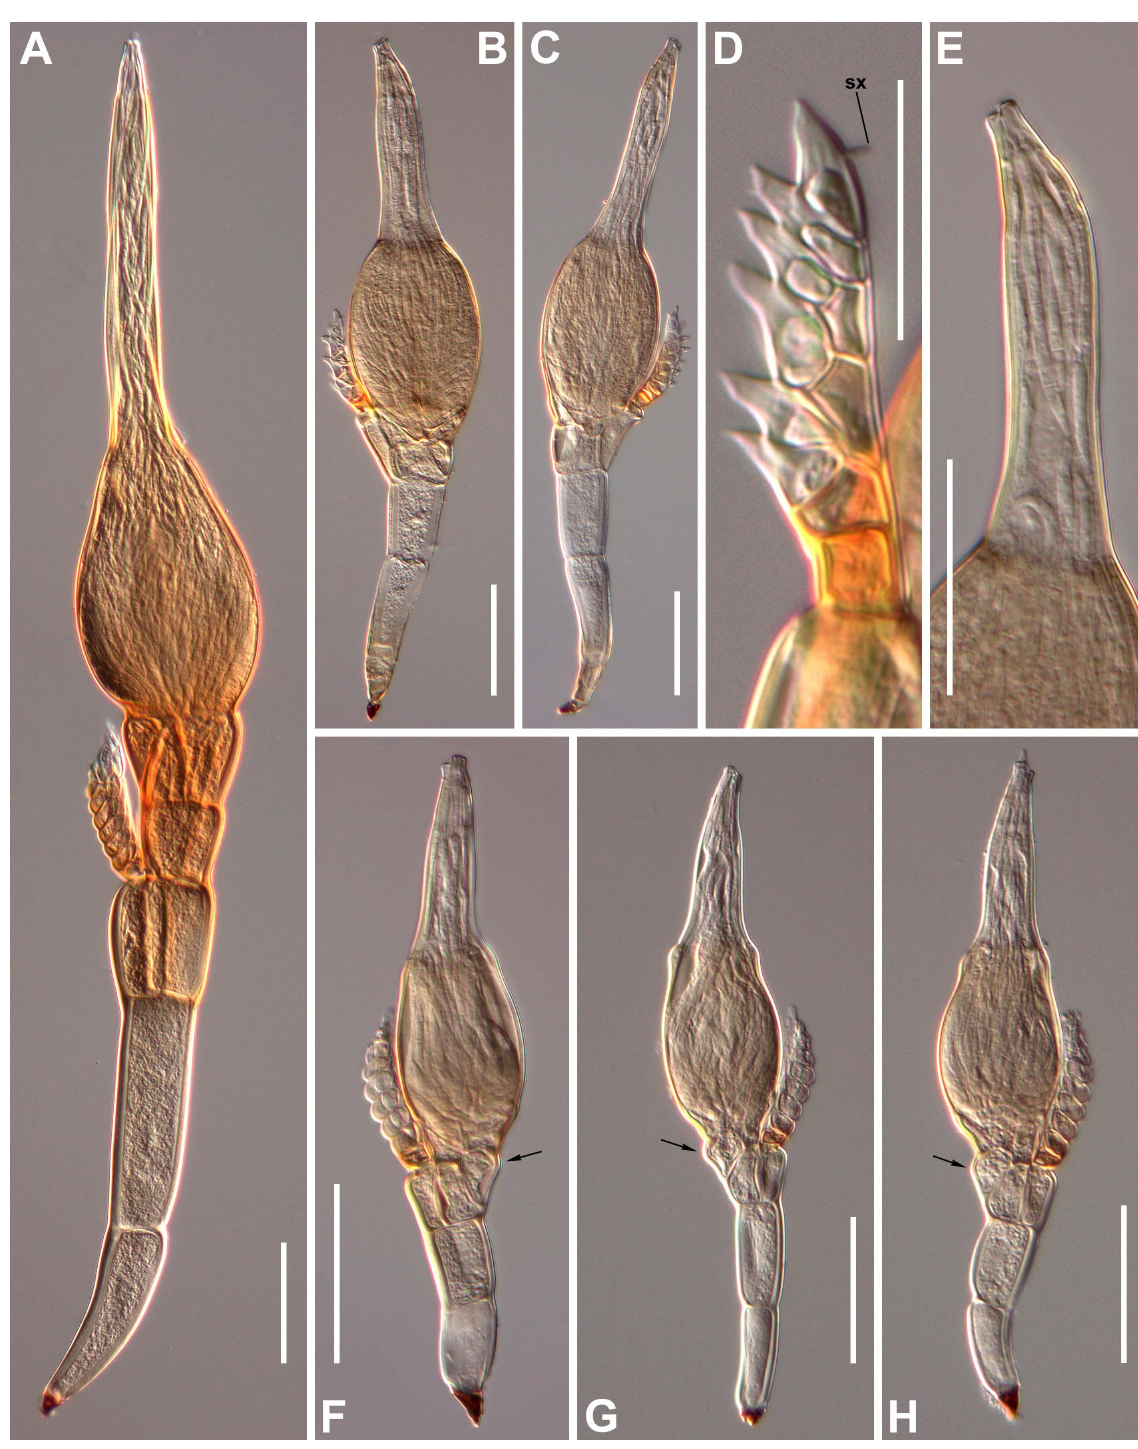
Fig. 60. Stigmatomyces spp. A . S. limosinae Thaxt. Mature thallus. – B – E . S. majewskii H.L.Dainat, Manier & Balazuc. B – C . Mature thalli. D . Primary appendage in detail with labelled spinous process from the original spore apex (sx). E . Perithecial tip in detail. – F – H . S. platensis Speg. Mature thalli showing protrusion of cell VII (arrows). Scale bars: A–C, E–H = 50 µm; D = 25 µm. Photographs from slides ZMUC C-F-123718 (A), ZMUC C-F-123705 (B, D–E), ZMUC C-F-123731 (C), ZMUC C-F- 123713